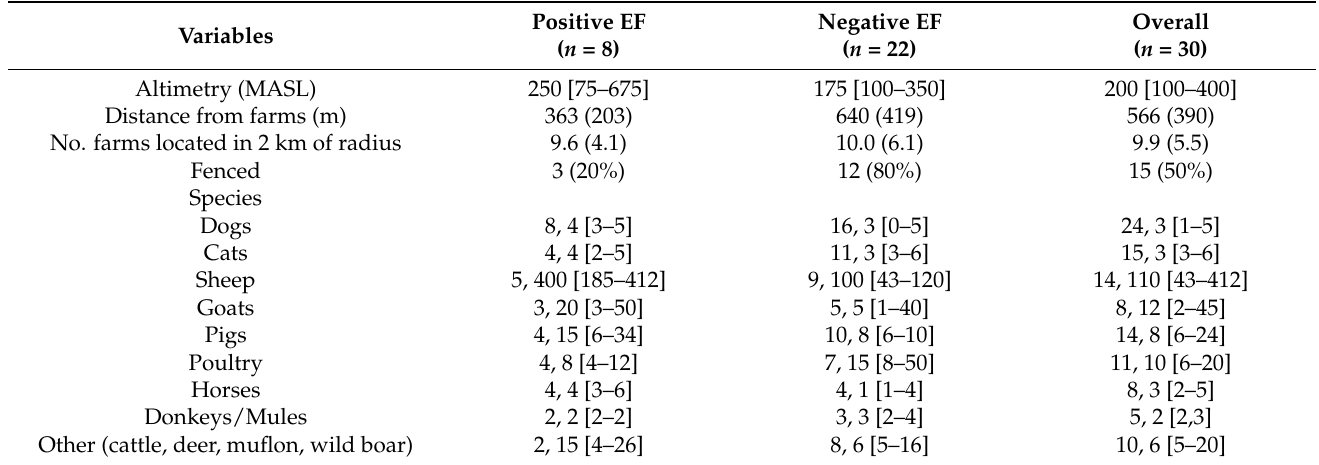
Table 5. Distribution of the baseline variables characterizing the 30 educational farms involved. Data are presented as mean (SD), or number of EF and median [I-III quartile], or number of EF (percentage,